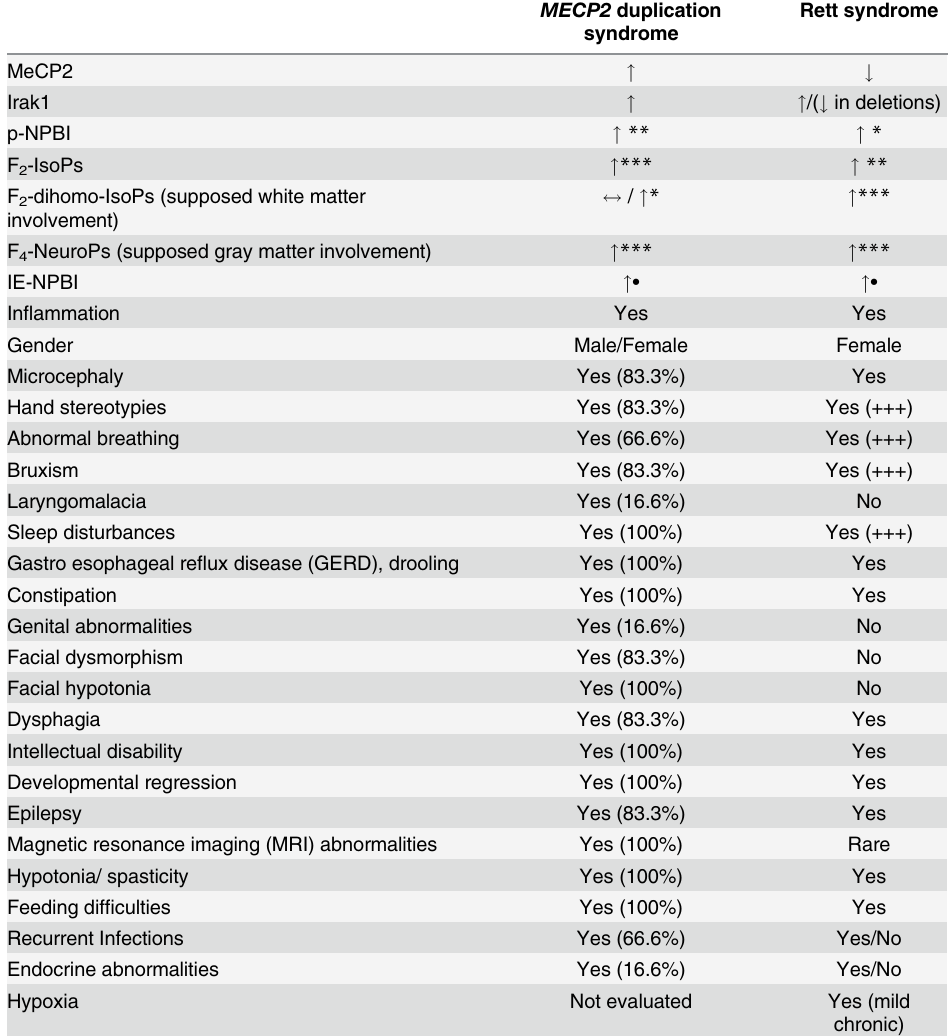
Table 3. Commonalities and differences between MECP2 duplication syndrome and Rett syndrome.